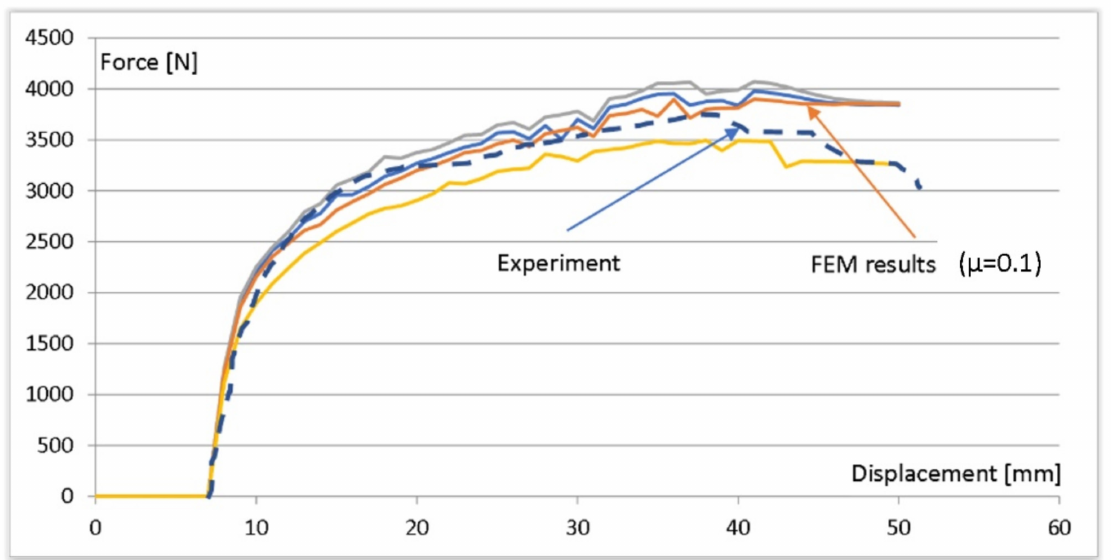
Figure 13. Comparison of force during loading for the friction-coefficient establishment (console 40 mm × 40 mm; arrow